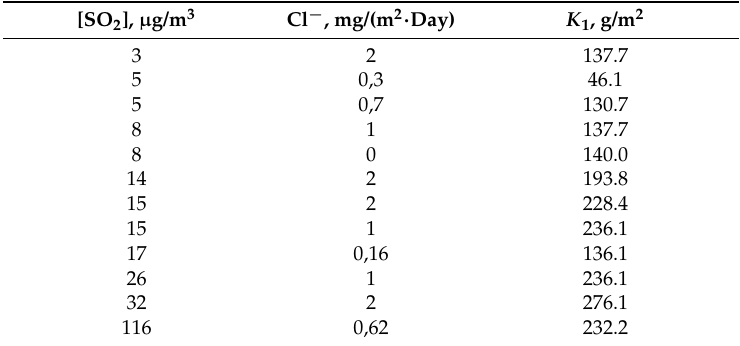
Table 5. Atmosphere corrosivity parameters and first-year corrosion losses of carbon steel in test locations. Adapted from [19], with permission from © 1999